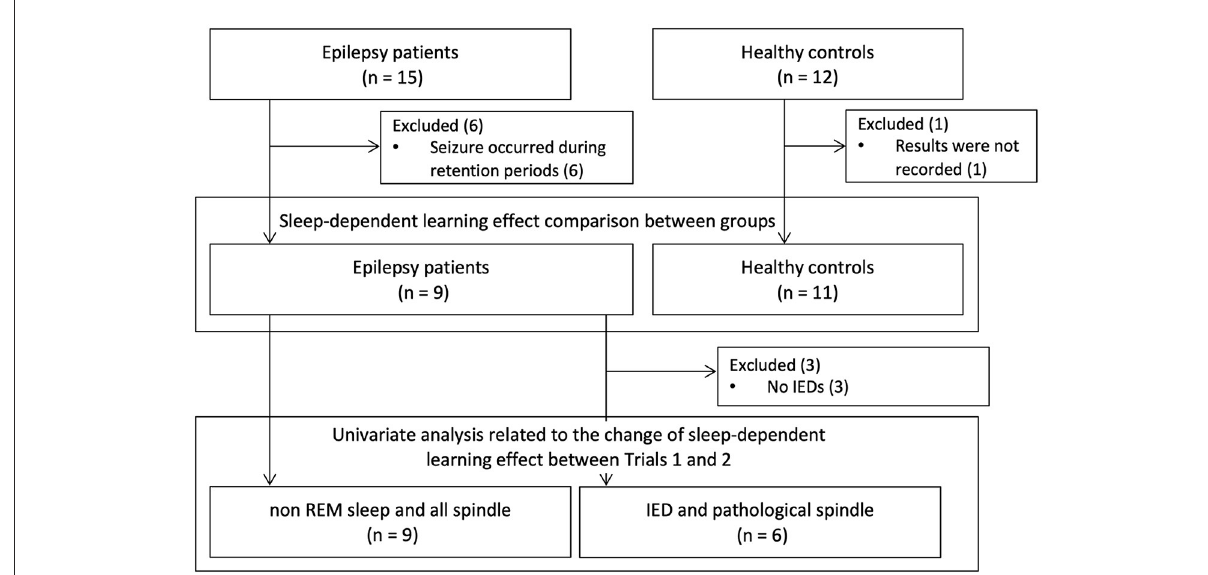
FIGURE2 Study population. Fifteen patients with epilepsy and 12 healthy subjects were recruited. Excluding six patients who had epileptic seizures the night after training and one healthy subject whose recordings were defective, we compared sleep-dependent learning effects between nine patients and 11 healthy controls. Then, we exploratively analyzed the factors associated with changes in sleep dependent-learning effect between Trials 1 and 2. When we analyzed about IED and pathological spindle, we excluded three patients who did not have any IEDs. IED, interictal epileptic